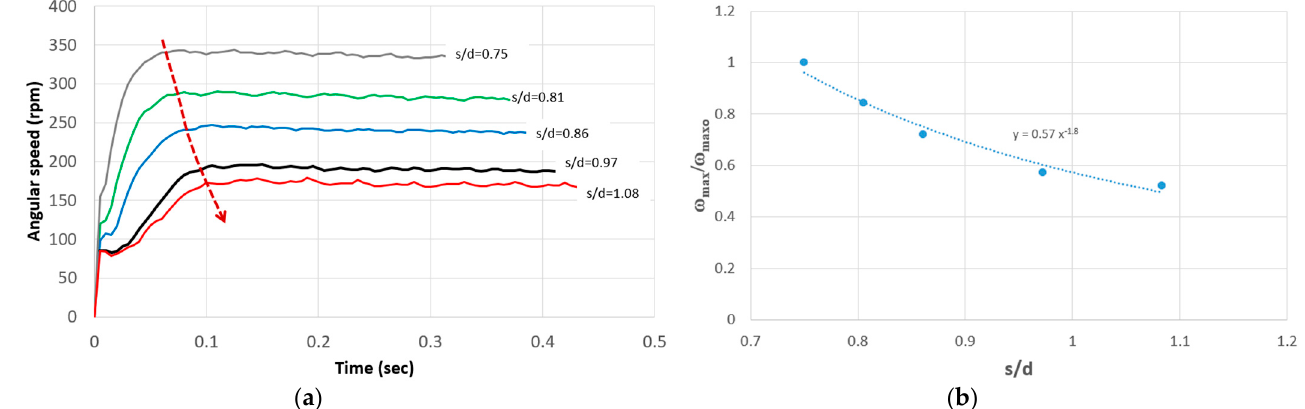
Figure 13. Effect of the pipe outlet-rotor gap distance on the gained rotor’s angular speed: ( a ) Tem- poral variation with time, ( b ) Maximum rotor’s angular speed.